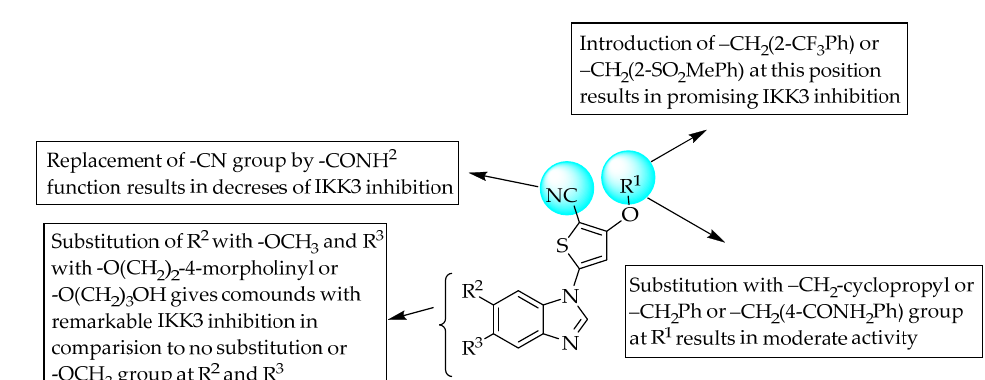
Figure 25. SARs of 6-(3-trifluoromethylpyridin-2-yl) benzimidazoles.